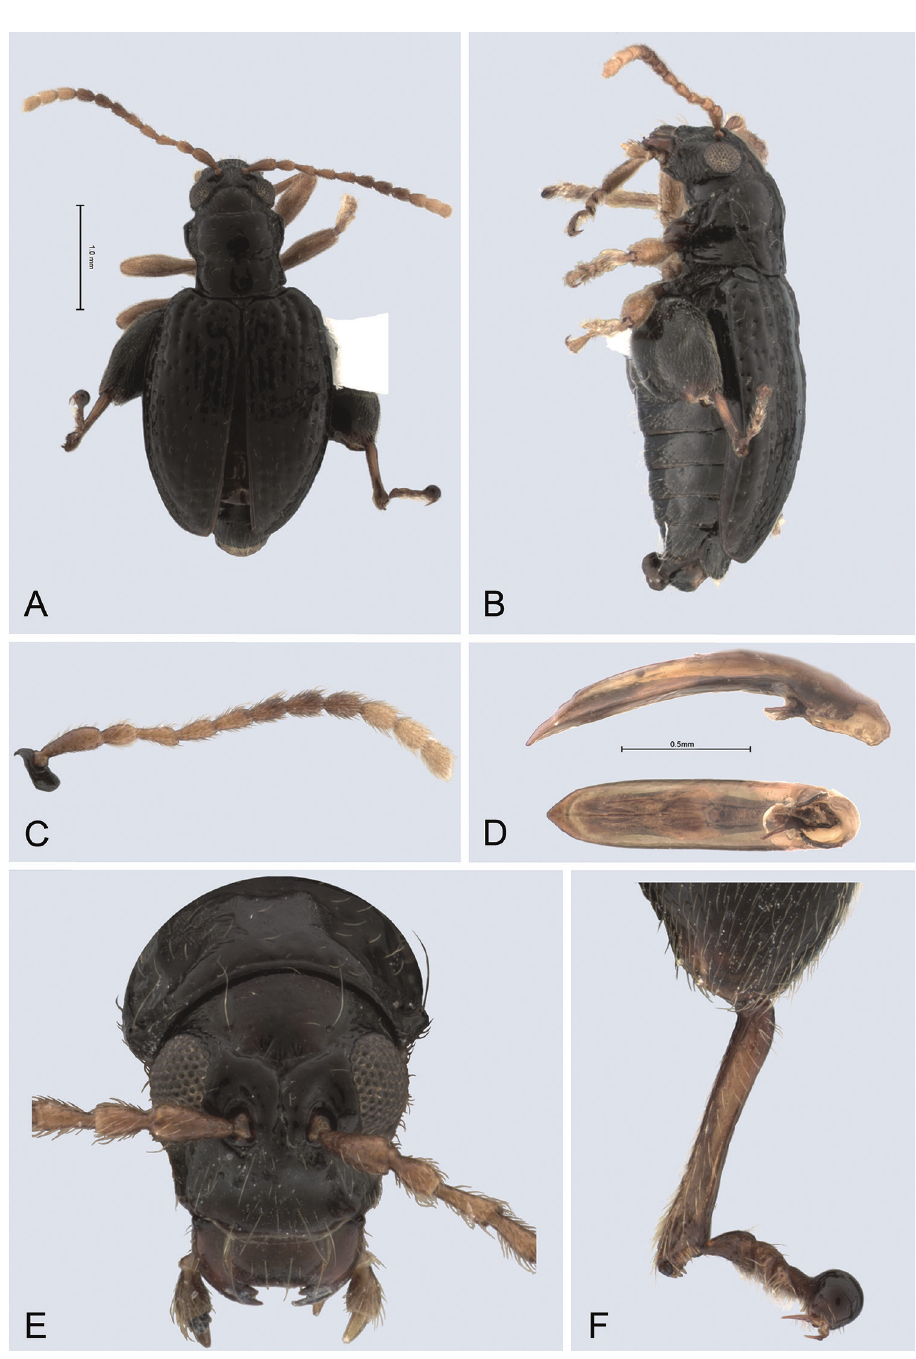
Figure 14. Andersonoplatus laculata . A Habitus dorsal B Habitus lateral C Antenna D Median lobe of aedeagus, ventral and lateral views E Head, frontal view F Hind